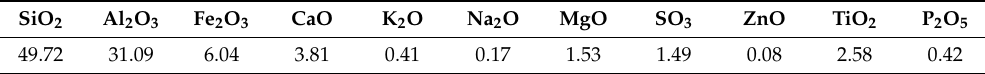
Table 2. Chemical composition of the FA